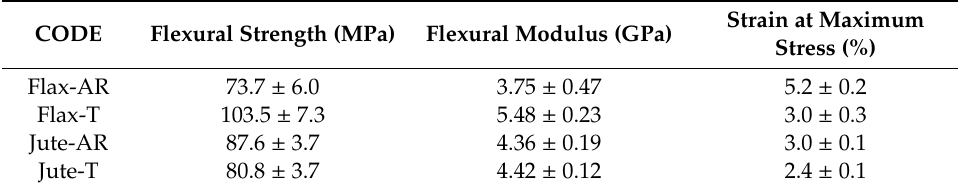
Table 2. Flexural properties of monolithic laminates.